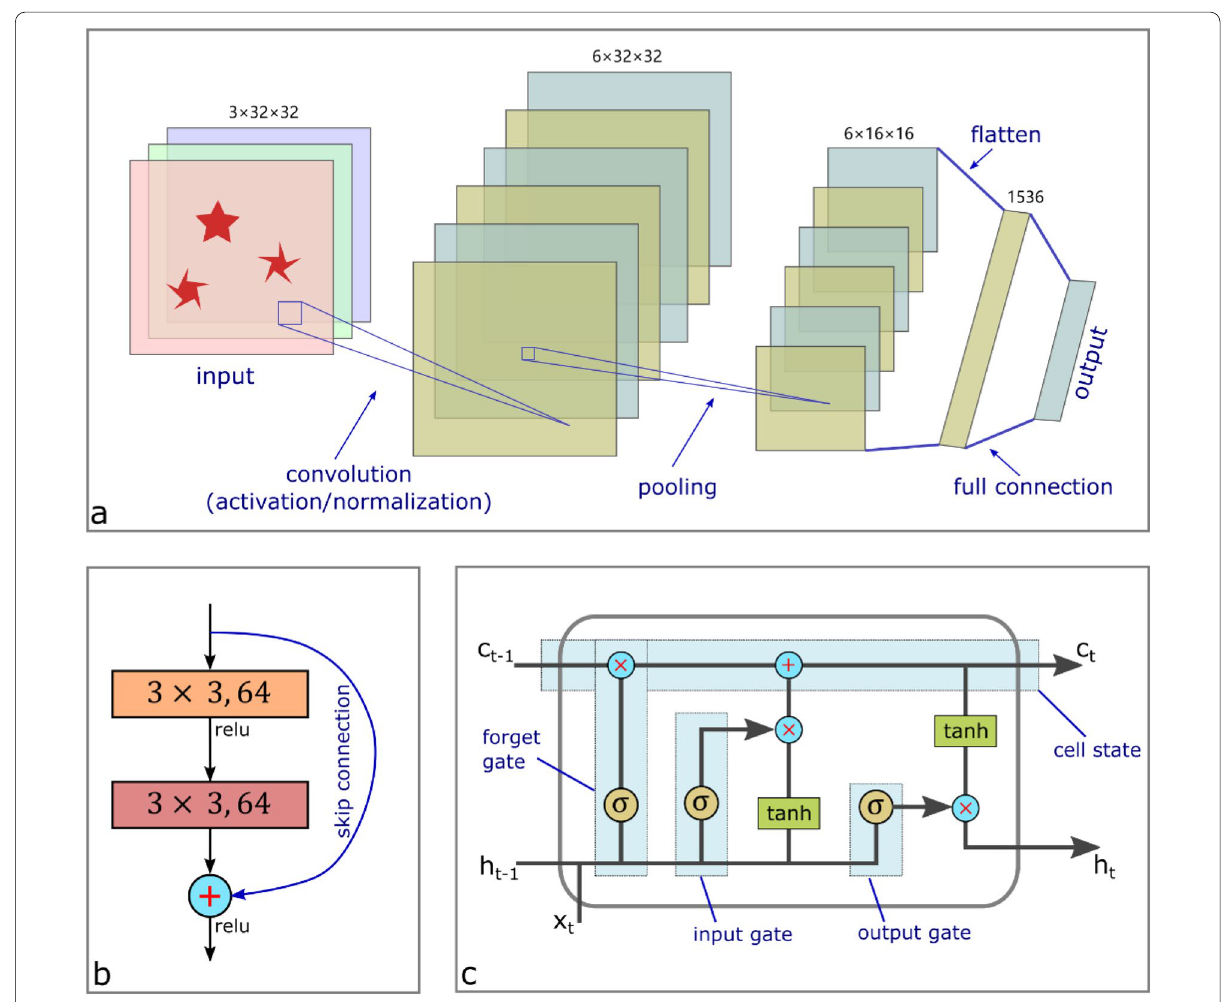
Fig. 4 Building blocks of a CNNs, b ResNet, and c LSTM